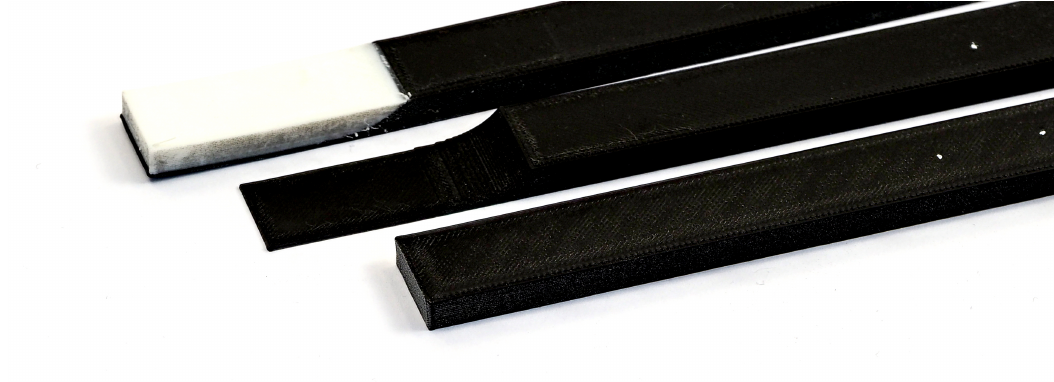
Figure 2. Overview of beam specimens with different system complexity: simple beam structure made of PLA ( front ), beam structure with an ABH made of PLA ( center ), and beam structure with an ABH made of PLA with an additional damping treatment made of an thermoplastic polyurethane ( back ).